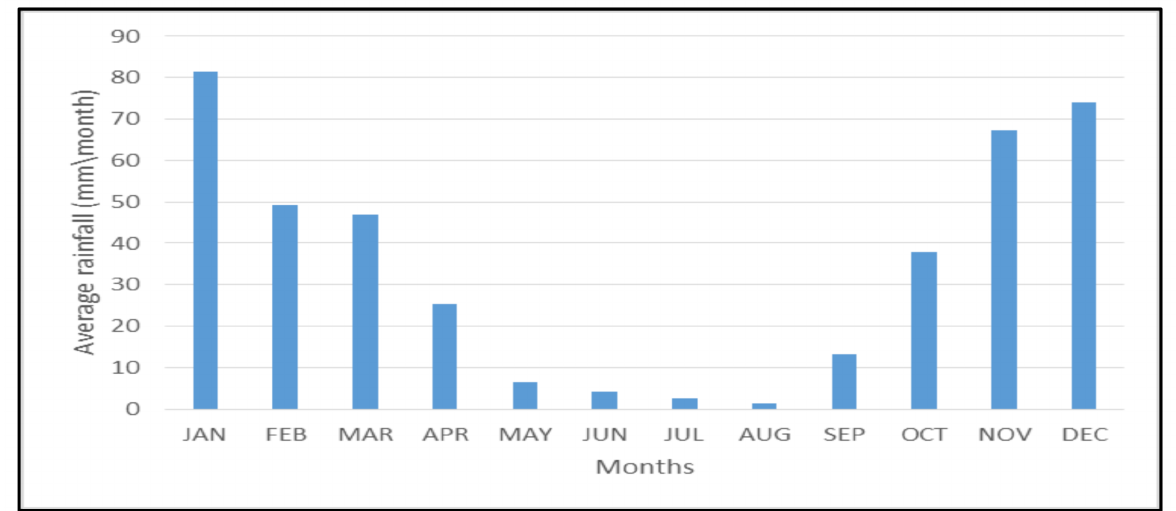
Figure 2. Mean monthly average rainfall of Mpumalanga Province